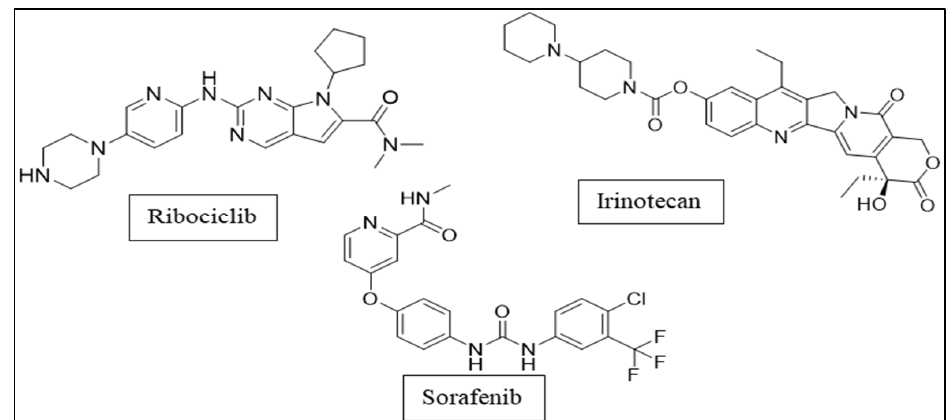
Figure 1. The chemical structures of the positive controls.